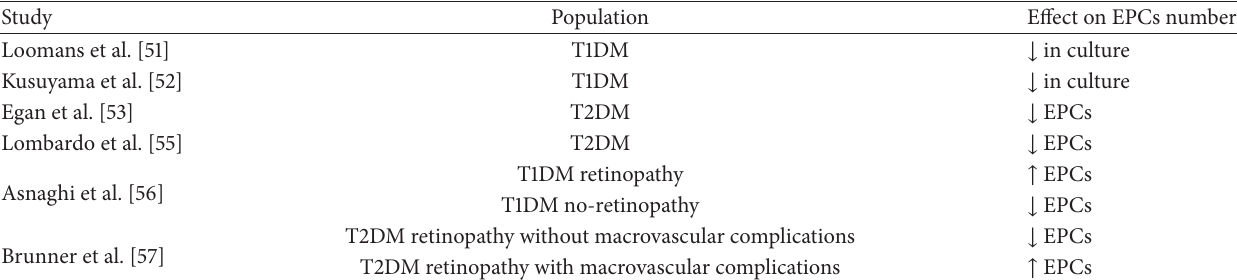
Table 3: Diabetes and